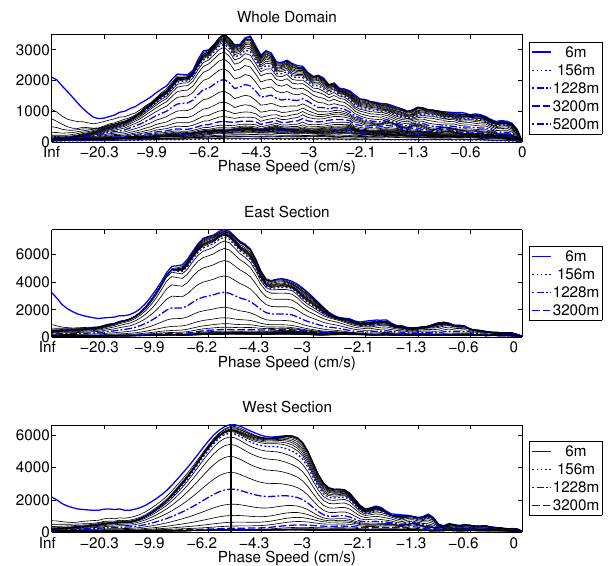
Fig. 3. The non-normalized amplitude of the Radon transform with phase speed for (a) the whole domain, (b) the East Atlantic and (c) the West Atlantic. Black vertical lines indicate the dominant phase